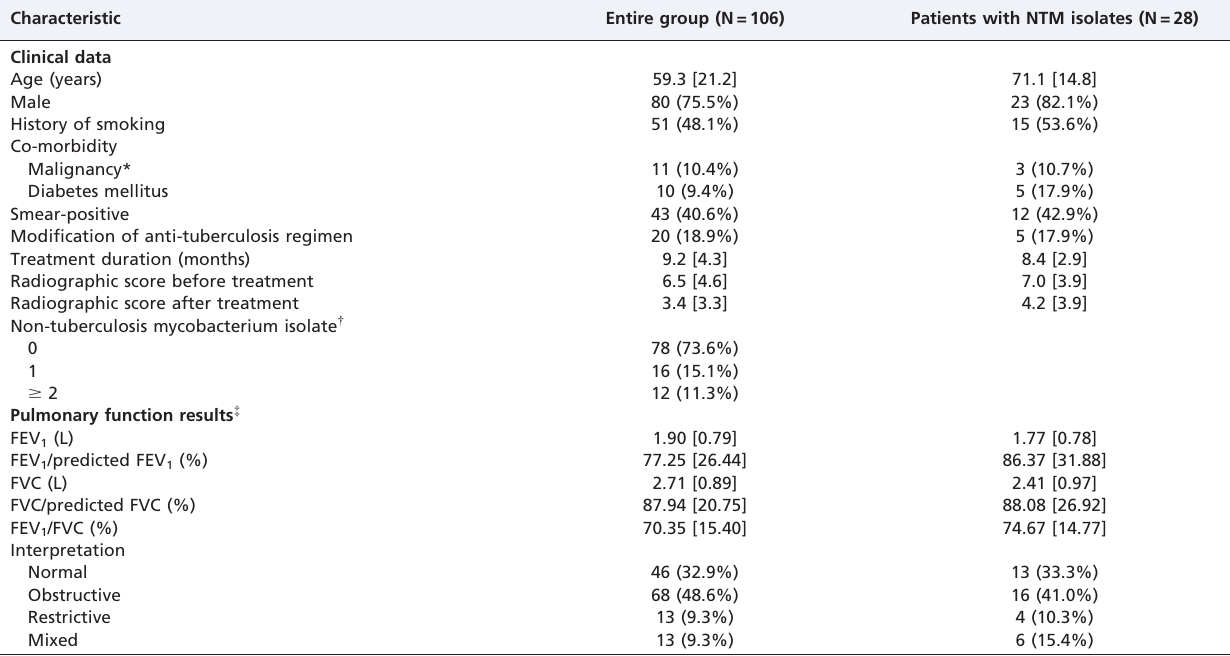
Table 1 - Clinical data and pulmonary function